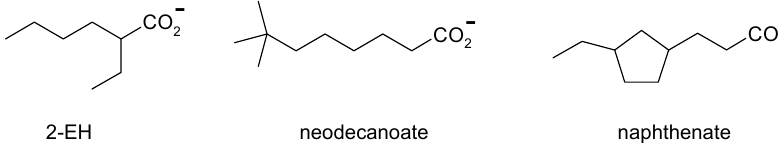
Figure 2. Structures of carboxylates of cobalt soaps used in alkyd resin paints. Both neodecanoate and naphthenate are each mixtures of isomers and only a typical component present in neodecanoate and naphthenate is shown, respectively.